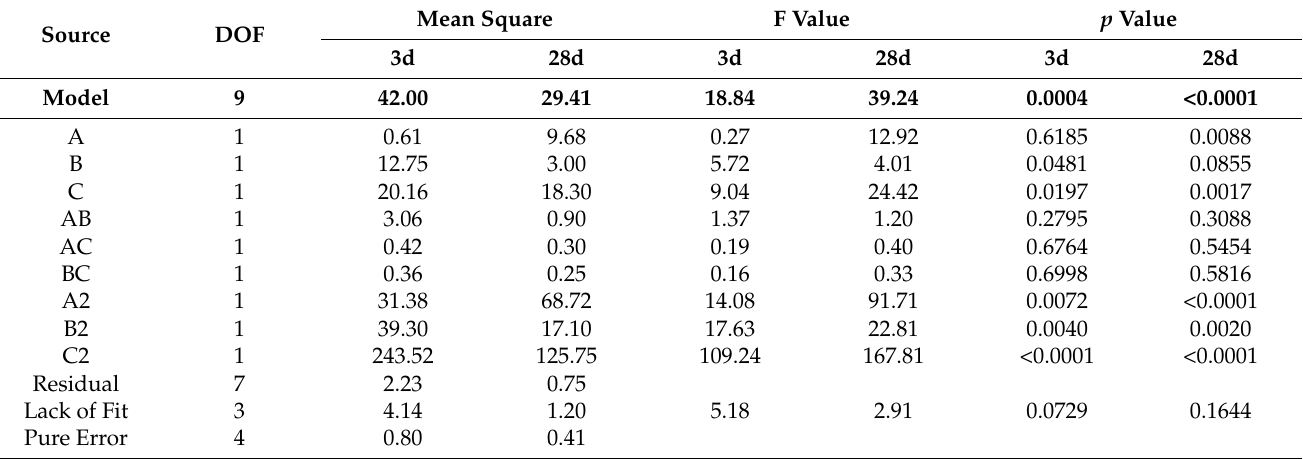
Table 5. Analysis of variance of simulation